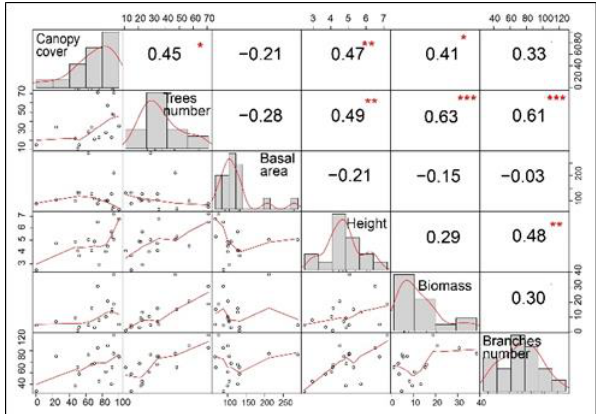
Figure 5. Correlation by Kendell’s tau for degraded forest plots (n= 19). p< 0.05 *, p<0.01 **, p<0.001